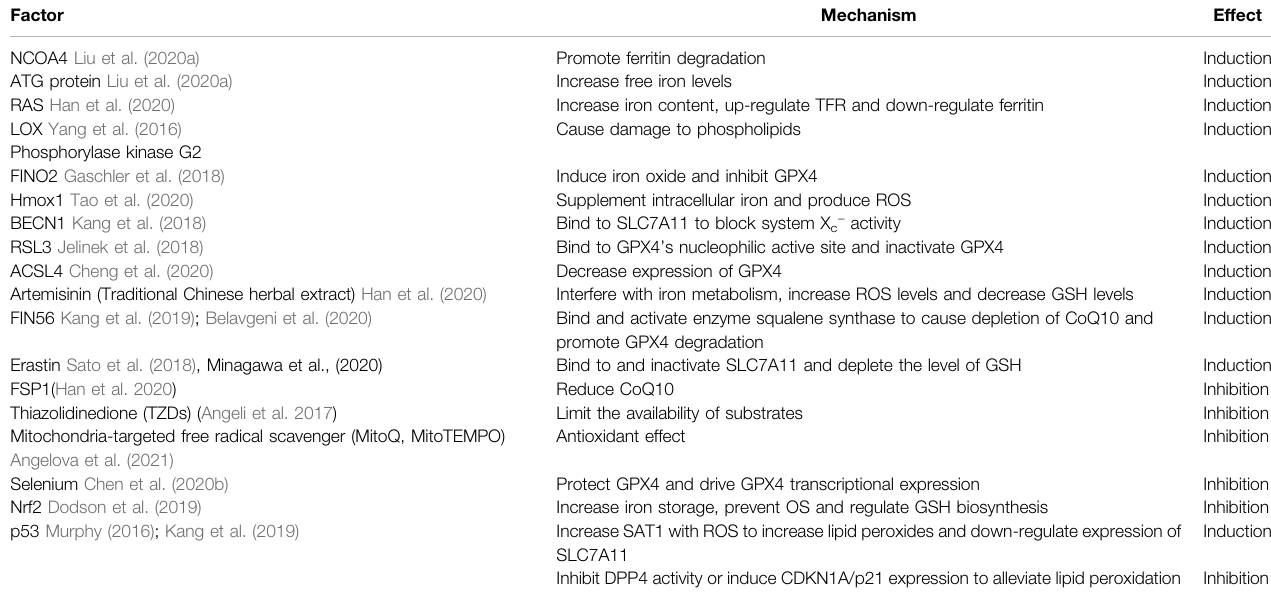
TABLE 1 | Initiators and inhibitors of